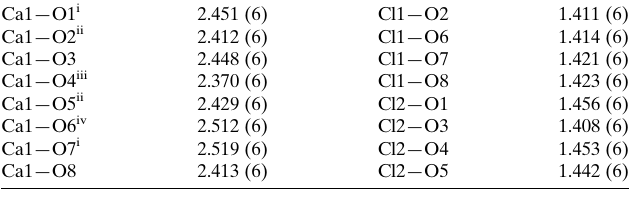
Table 1 Selected bond lengths (A˚ ).